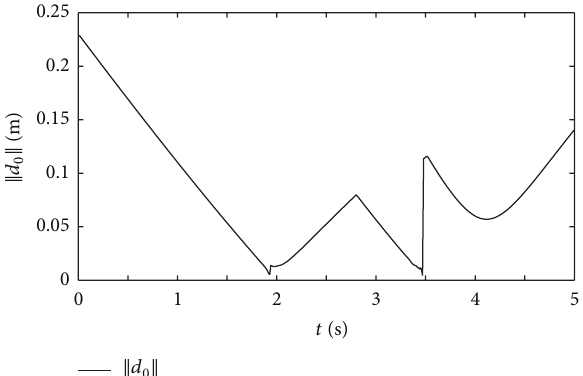
Figure 9: Closest distance using the traditional approach.